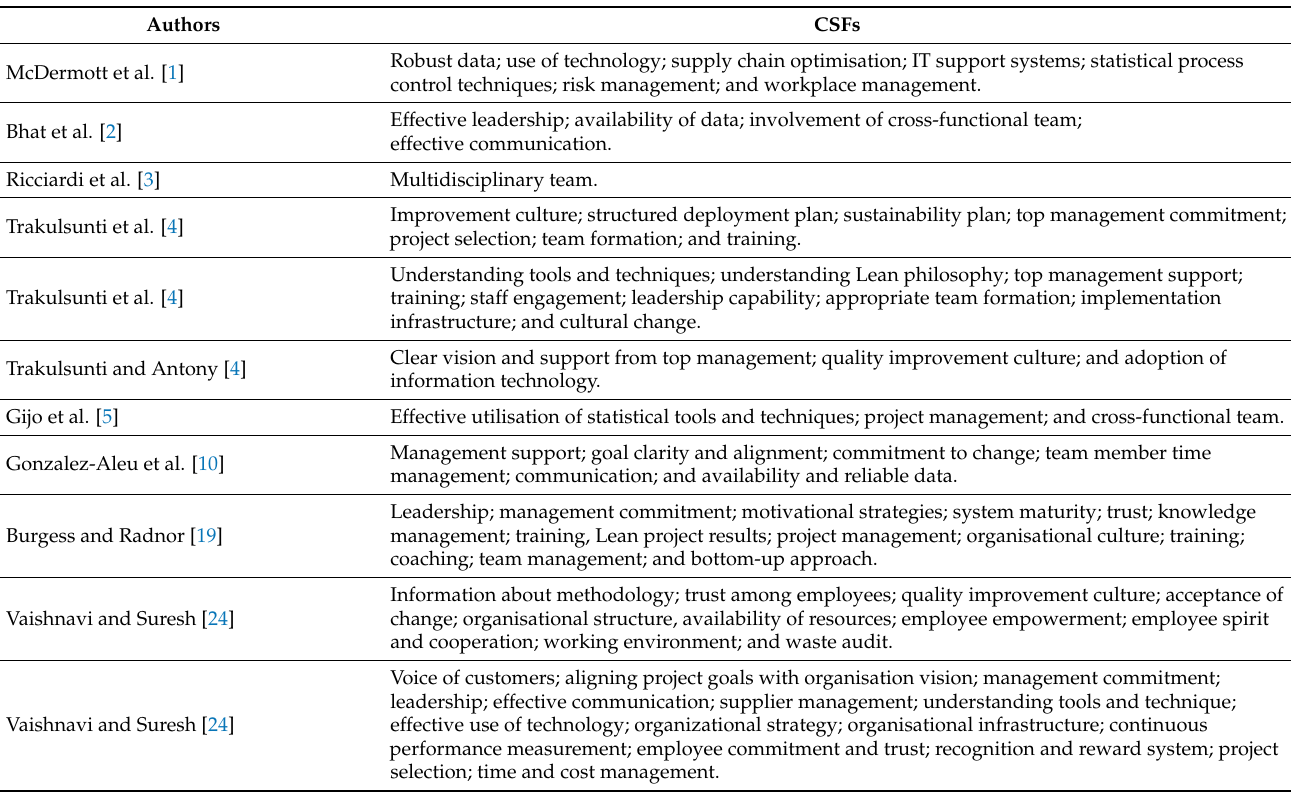
Table 2. CSF’s of LSS in